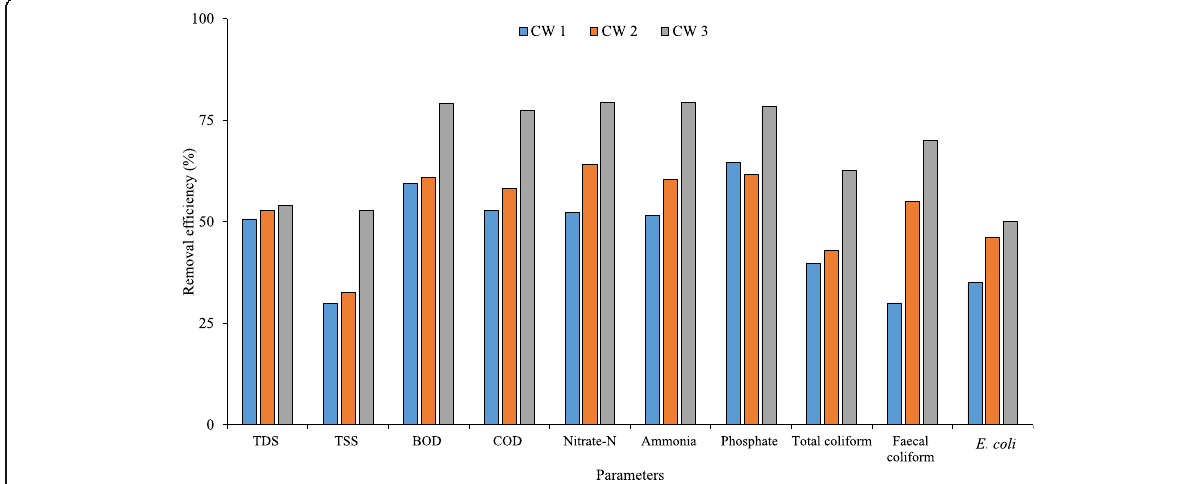
Fig. 2 Removal efficiency of various parameters of primary treated sewage through different setups of constructed wetland